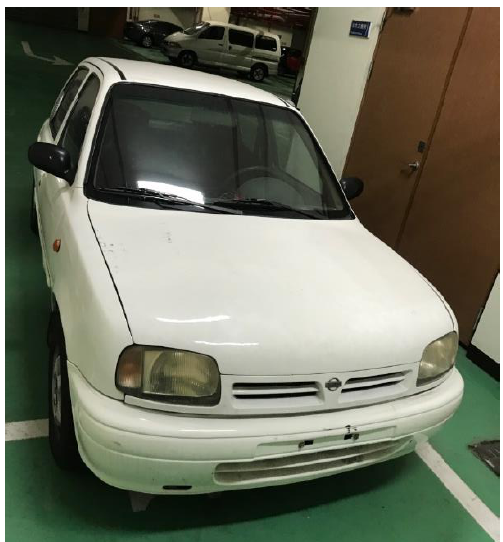
Figure 6. Electric vehicle modified from a gas-powered sedan for experimental tests.